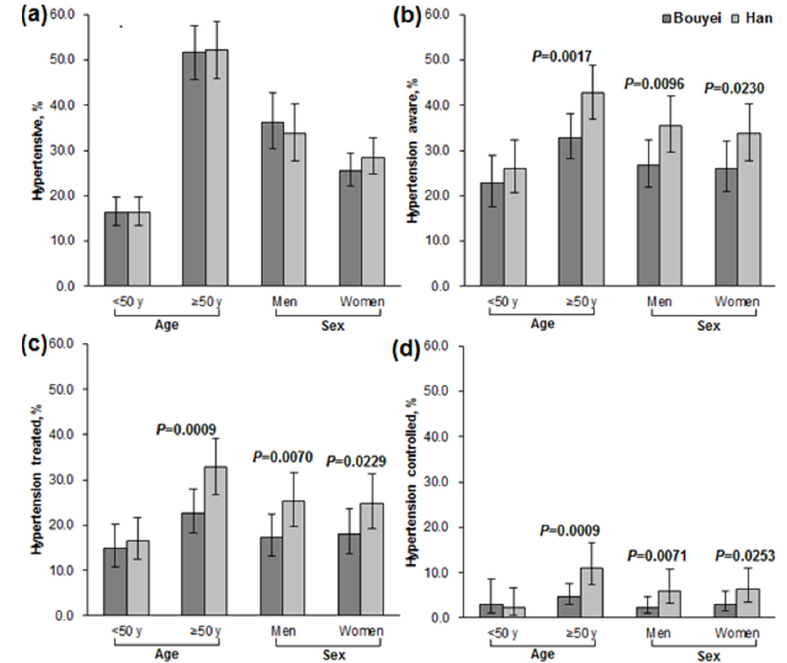
Figure 2. Comparing adjusted prevalence, awareness, treatment, and control by Age and Sex. Error bars indicate limits of 95% CI. ( a ) Adusted prevalence of hypertension in Bouyei and Han; ( b ) Adjusted rates of awareness in hypertensive Bouyei and Han; ( c ) Adjusted rates of treatment in hypertensive Bouyei and Han; ( d ) Adjusted rates of control in hypertensive Bouyei and Han.